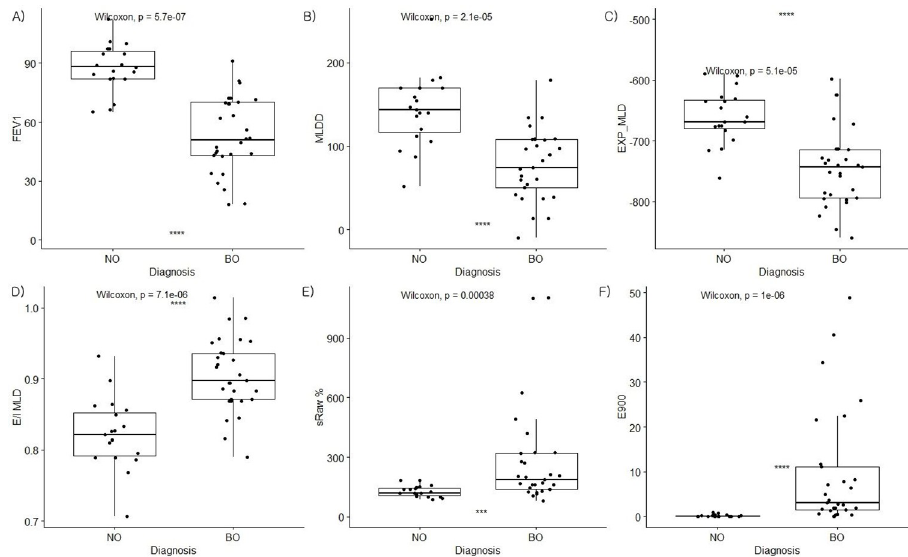
Fig 2. Comparison of quantitative lung densitometry indices and conventional pulmonary function test results according to diagnosis.